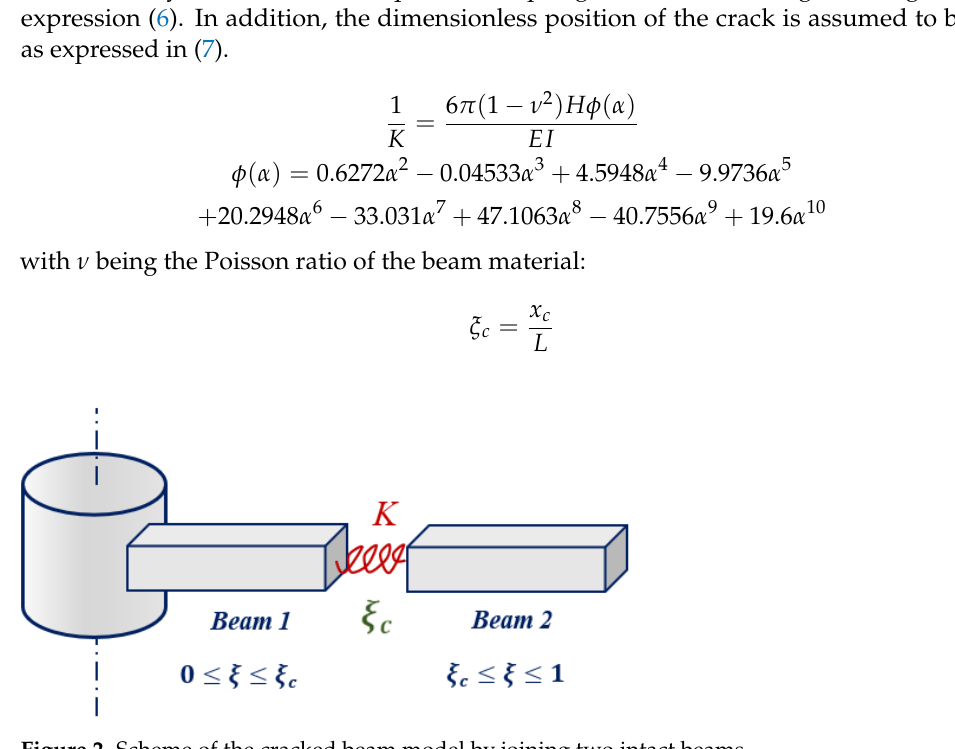
Figure 2. Scheme of the cracked beam model by joining two intact